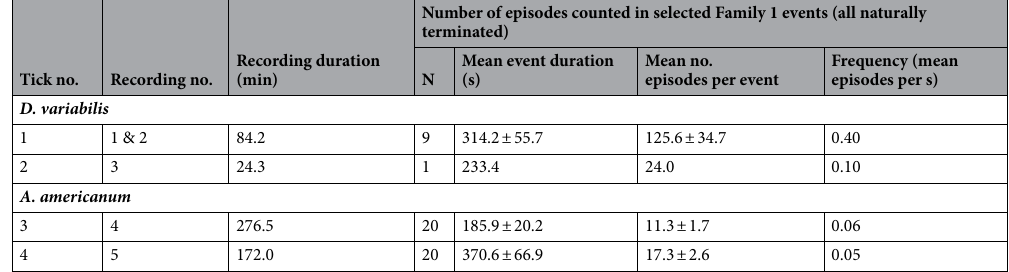
Table 1. Descriptive statistics for early, slow-phase feeding episodes of adult, female D. variabilis and A. americanum Family 1 waveforms measured within naturally terminated events. Mean ± standard errors.